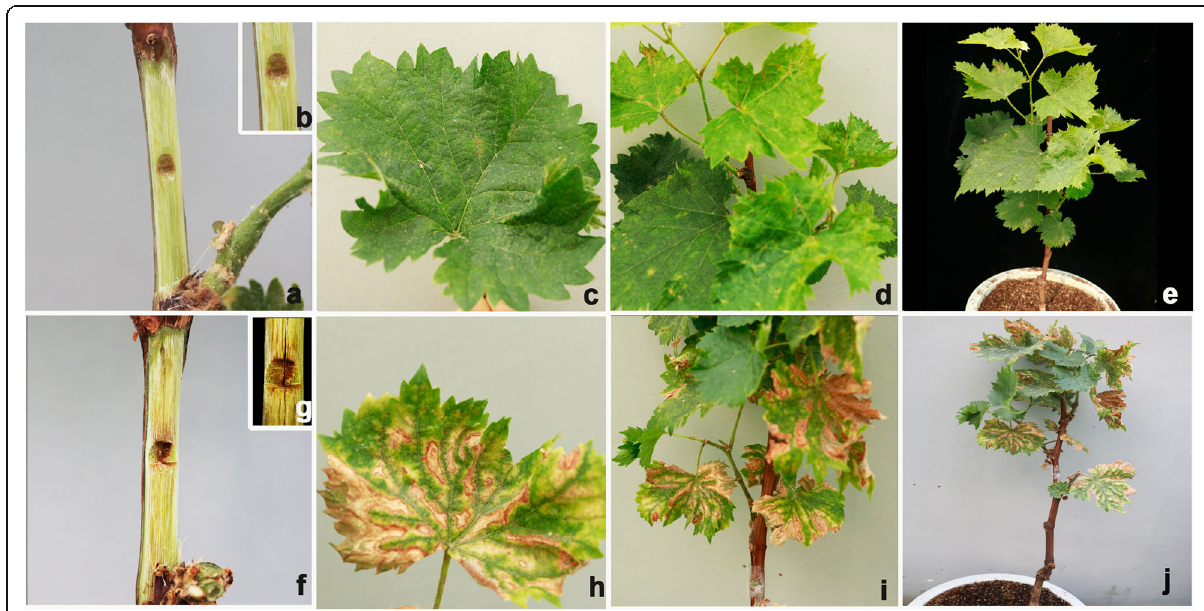
Fig. 5 Pathogenicity test of Fomitiporia punicata in the greenhouse. a – e Control plant. f – j The plant (cv. Cabernet, 2-year-old) inoculated with F. punicata showed interveinal discolorations and necrosis on leaves and black necrosis within the trunk at 3 months post-inoculation